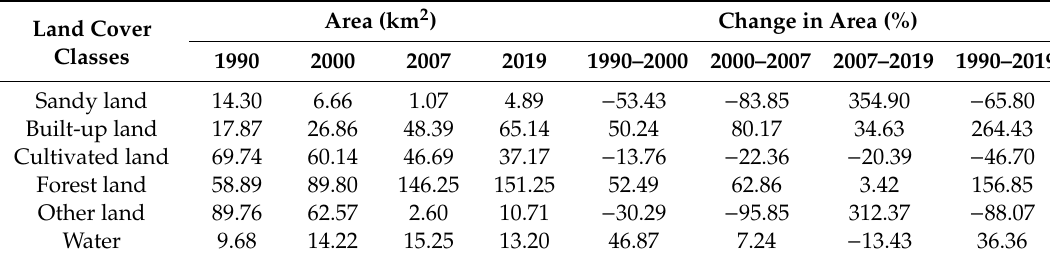
Table 4. Summary of land cover classes and change on Haitan Island,